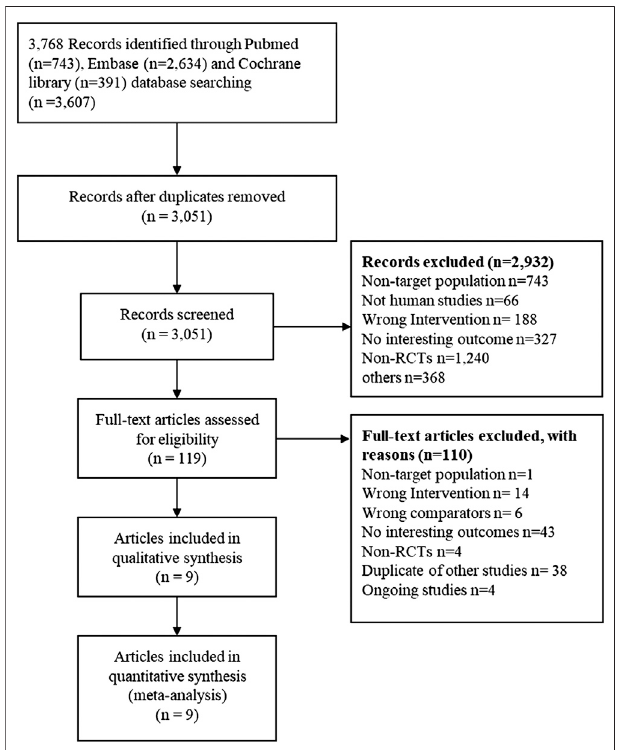
FIGURE 1 | The PRISMA 2009 flow diagram for literature screening. RCTs randomized controlled